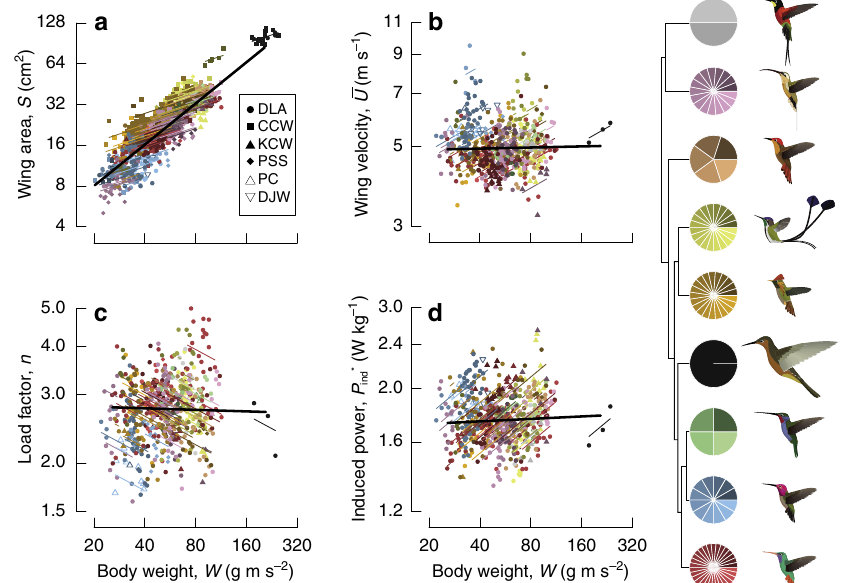
Fig. 3 Allometric divergence among and within species. We contrast the slopes of wing area ( a ), wing velocity ( b ), load factor ( c ) and induced power requirements ( d ). The slope of each variable on body weight among species is shown in black, and each was calculated allowing for phylogenetic non- independence and measurement error. Individual records are shown along with the mean within-species slope fi t through the respective empirical species means. Symbols denote collector. Individual observations and within-species slopes are coloured and shaded by species within clade, according to the cartoon phylogeny at right (colours as in Fig. 1). Sample sizes are provided in Supplementary Table